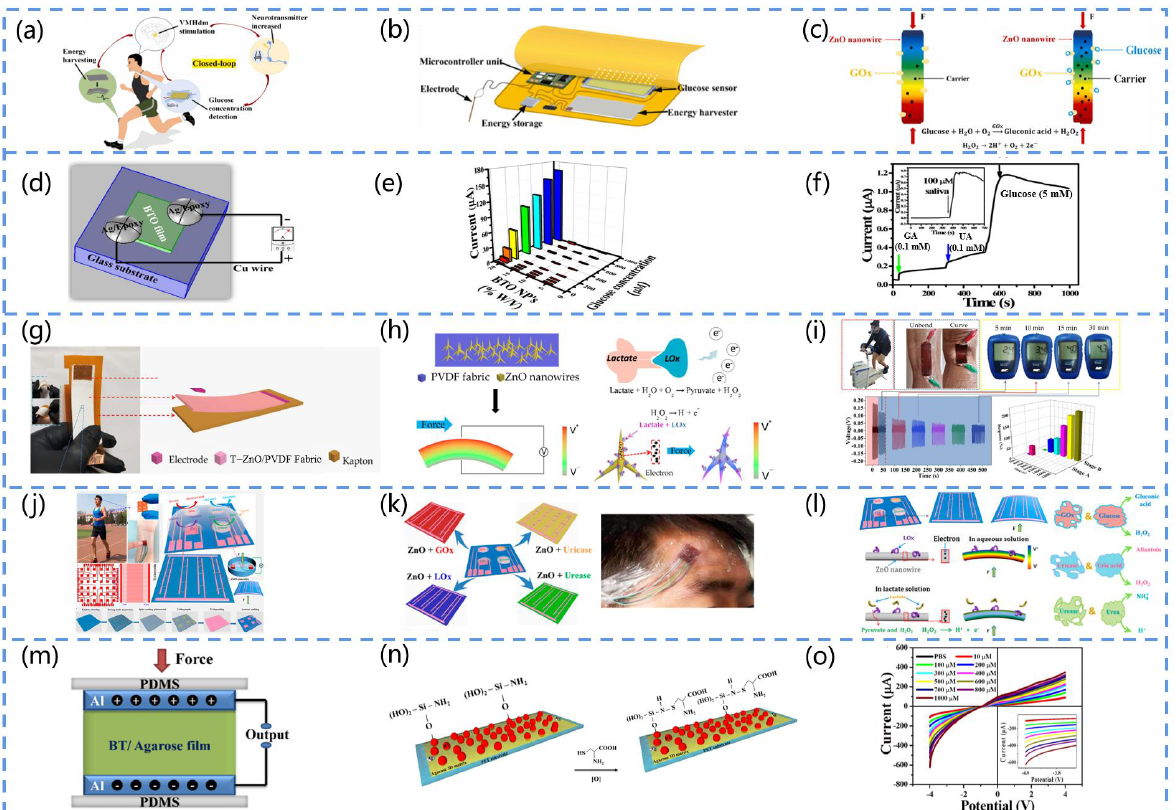
Figure 9. ( a ) Schematic diagram of the blood glucose monitoring sensor and brain – computer inter- face used to build a closed loop. ( b ) Components of the blood-glucose-sensing system. ( c ) Sensing mechanism of the device ( F represents force). Reprinted with permission from [106]. Copyright 2022, Elsevier. ( d ) Schematic diagram of the BTO-NP-based sensor. ( e ) Three-dimensional graph of the current response of the BTO-NP-based glucose sensor at different concentrations (Glucose con- centration are 50 μ M~1 mM, BTO NP concentration are 5, 10, 15, 20% (w/v)). ( f ) I-T curves of glucose under interferences such as 0.1 mM galactose and 0.1 mM uric acid (Black arrows represent 5 mM glucose, green arrows represent 0.1 mM galactose, and blue arrows represent 0.1 mM uric acid). Reprinted with permission from [107]. Copyright 2016, Elsevier. ( g ) Schematic diagram of the struc- ture of the self-powered biosensor based on T-ZnO/polyvinylidene fluoride (PVDF)/fabric. ( h ) Dia- gram of the working mechanism of the device ( V represents voltmeter, the color of the rainbow indicates the magnitude of the output piezoelectric voltage). ( i ) Blood lactate concentration in the sweat of the test participant at different time points (5, 10, 15, 20, 25, and 30 min), stage A is the response of the biosensor in the phase from no sweating to sweating, stage B is the response of the biosensor to detect the sweat lactate concentration, F is force. Reprinted with permission from [109].